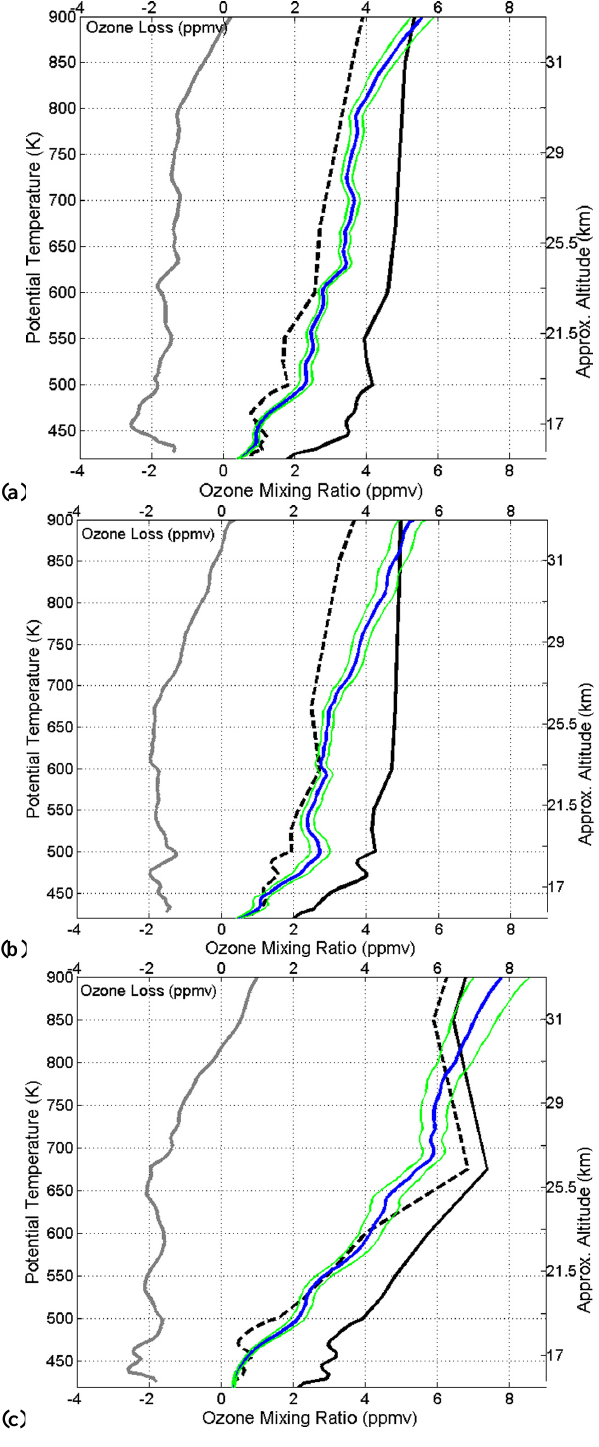
Fig. 9. Volume mixing ratio ozone profile measured by lidar (solid blue line) ± lidar error (solid green line) and calculated by MIMOSA-CHIM (black dashed line). Passive ozone profile is plotted as a black solid line. Ozone loss is calculated as lidar- passive ozone (gray solid line). (a) corresponds to 13 November, (b) 14 November, and (c) 23